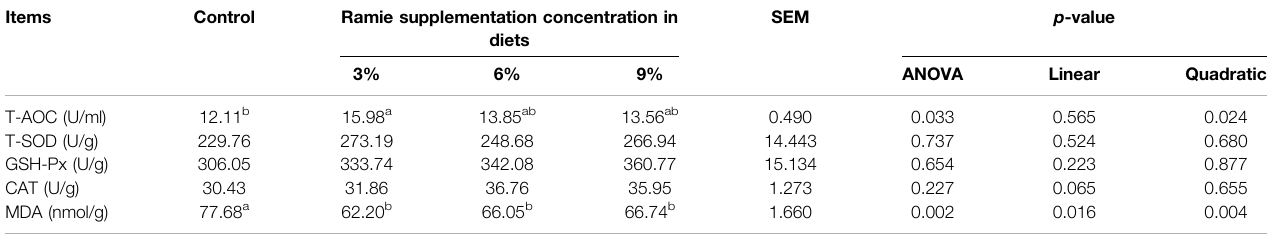
TABLE 4 | Effects of dietary ramie supplementation on Yolk Antioxidation Indices. Items Control Ramie supplementation concentration in